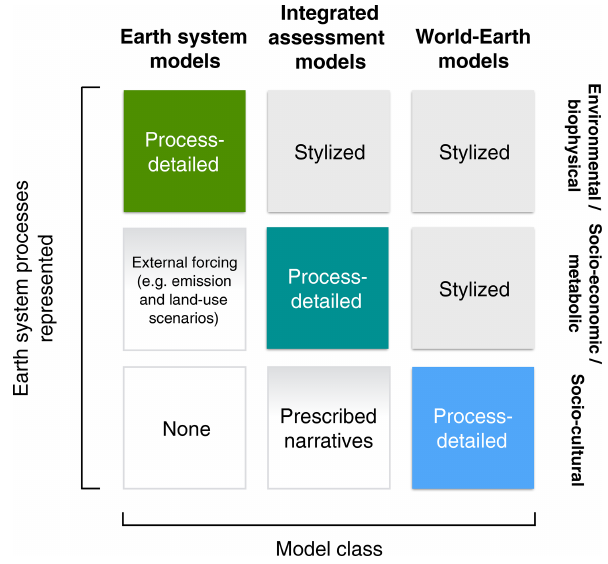
Figure 1. World–Earth models (WEMs) in the space of model classes used for scientific analysis of global change. It is shown to what degree current Earth system models, integrated assess- ment models and WEMs cover environmental or biophysical, so- cioeconomic or metabolic, and sociocultural processes. The term “process-detailed” indicates the types of Earth system processes that the different model classes typically focus on representing. However, also in these core areas the level of detail may range from very stylized to complex and highly